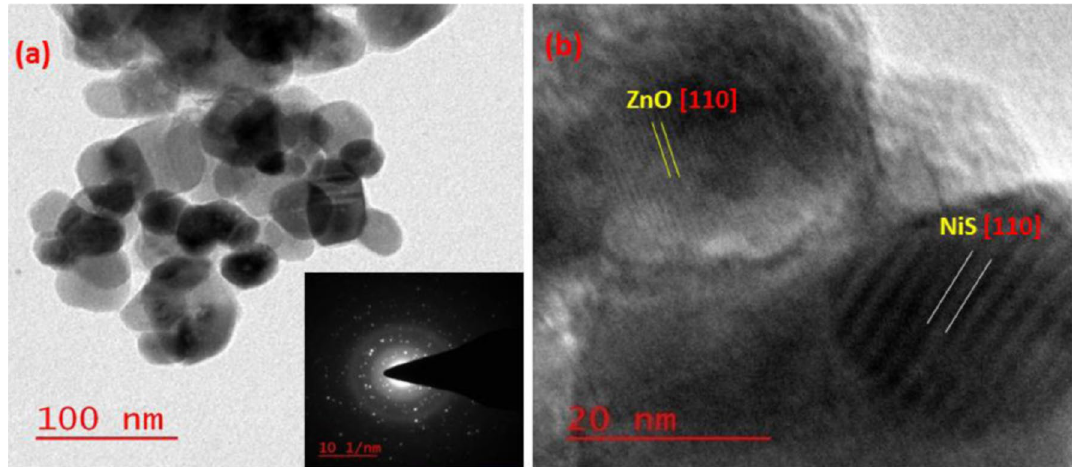
Figure 2. ( a ) TEM micrograph of NiS/ZnO (inset showing SAED), ( b ) HR-TEM of NiS/ZnO.